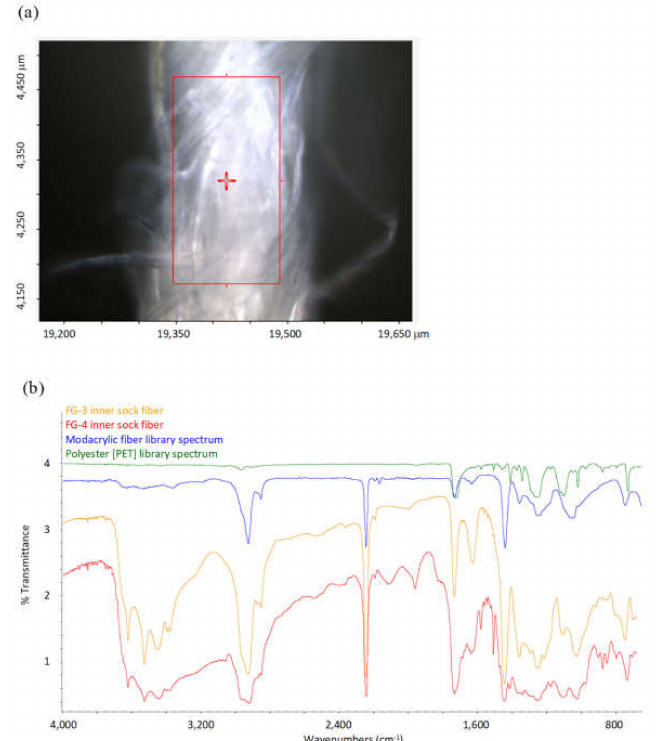
Figure 9. ( a ) FTIR microscope image of analyzed area of 200 um thickness, synthetic fiber bundle from inner sock material in FG-4. ( b ) FTIR microspectroscopy results (red spectrum) from ( a ). Also shown is a spectrum from the inner sock of FG-3 (orange). Both are good matches with the library spectra for modacrylic fibers containing vinyl chloride and antimony trioxide additives (blue). In addition, the synthetic fibers from FG-3 contain minor peaks matching PET